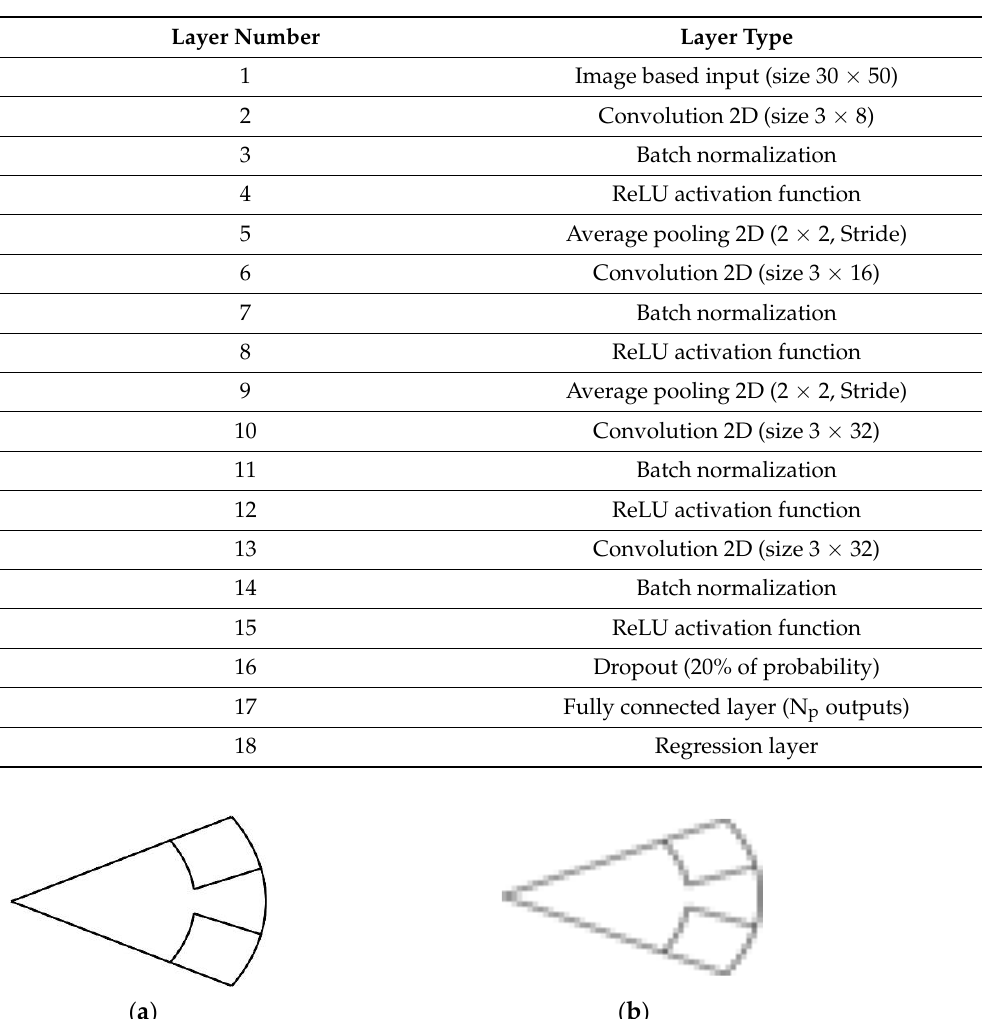
Table 1. CNN structure.